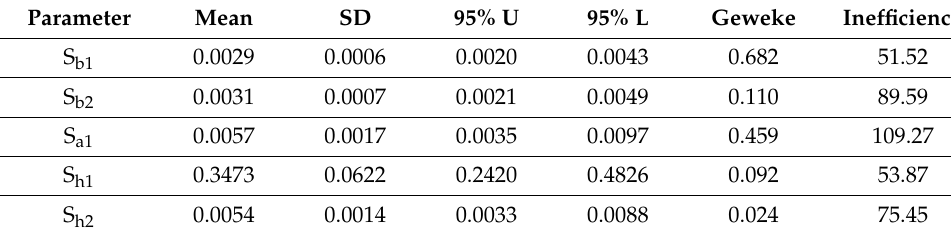
Table 2. Gibbs Sampling Validation Results (based on Korea Real Estate Board Price Index).